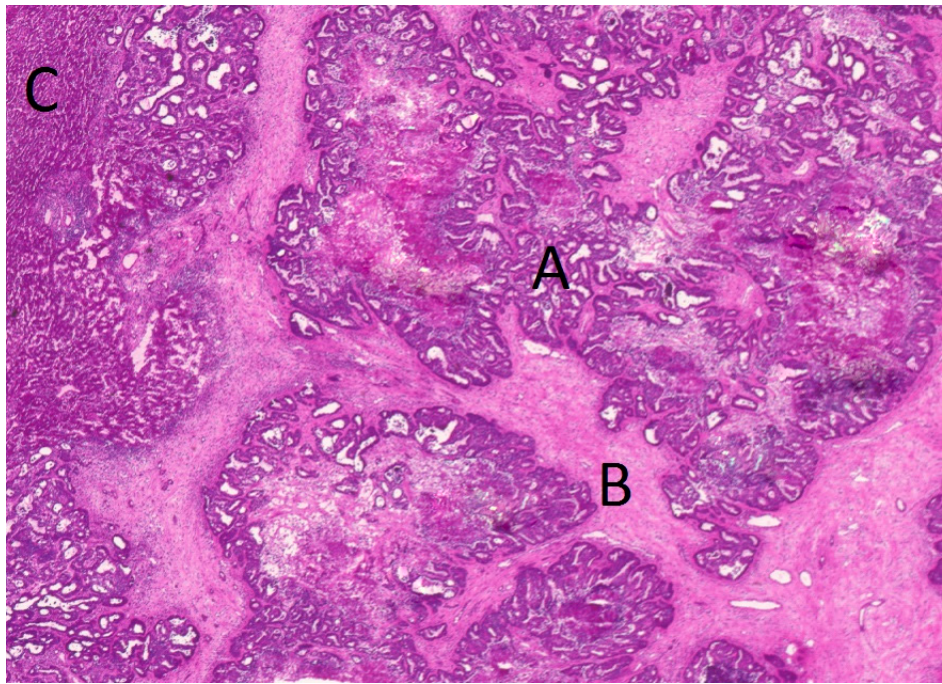
Figure 5. Hematoxylin and eosin (H-E) staining of a liver metastasis: A = tumor tissue, B = stroma tissue, C = liver host tissue. Scanned by Nikon Coolscan 5000 ED at 4000 dpi (Nikon, Tokyo, Japan)